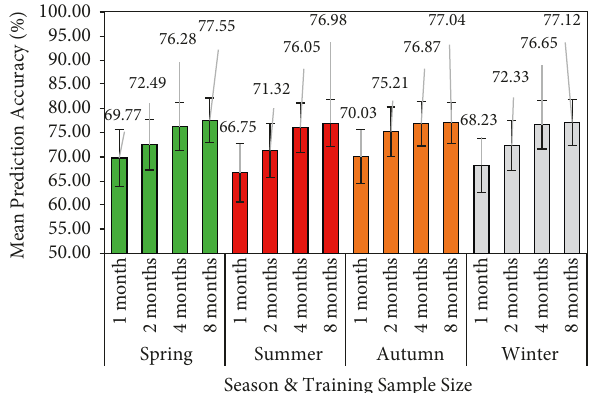
Figure 12: Model performance for different seasons and sample